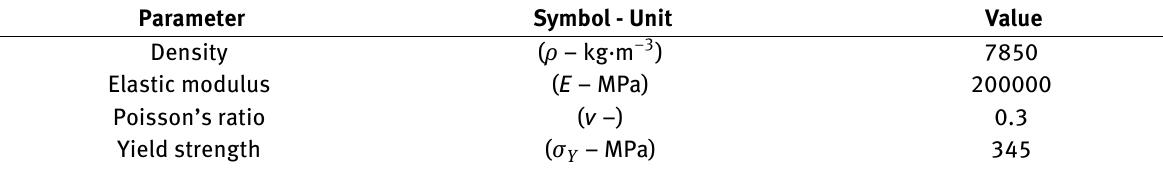
Table 5: Material properties of the hull structure